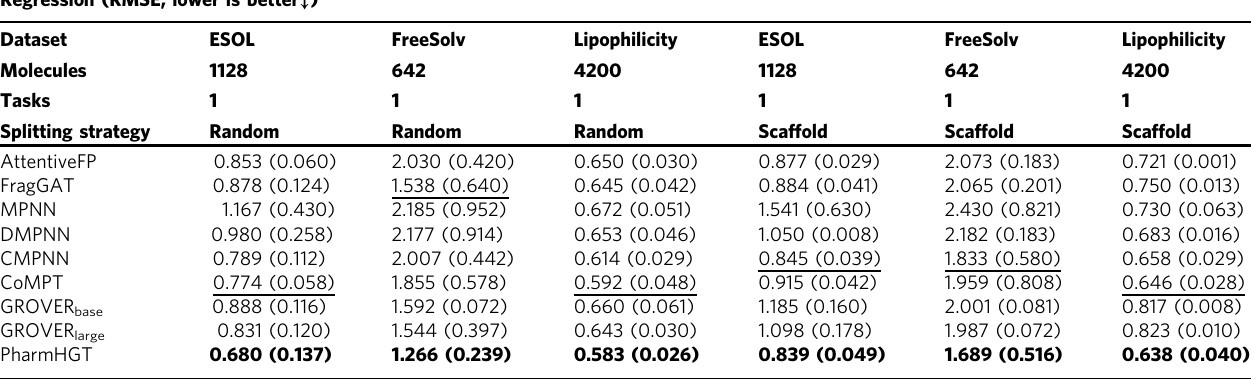
Table 2 Overall performance comparison to the state-of-the-art methods on molecular property prediction regression tasks. Regression (RMSE, lower is better ↓ )